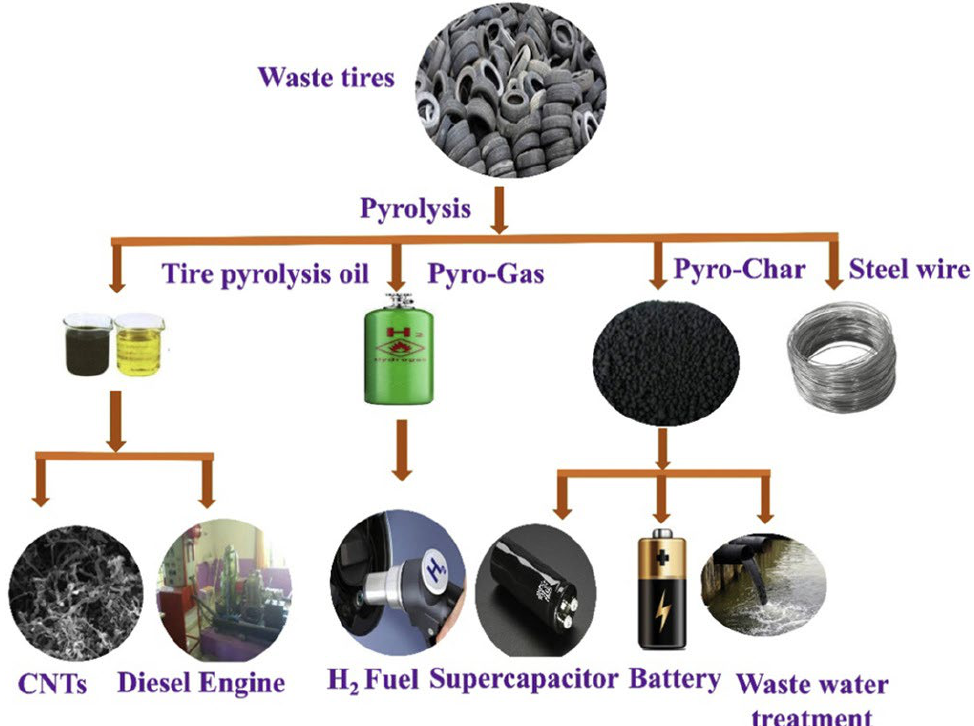
Figure 2. Classification of the different waste tire pyrolysis products with possible applications [21].